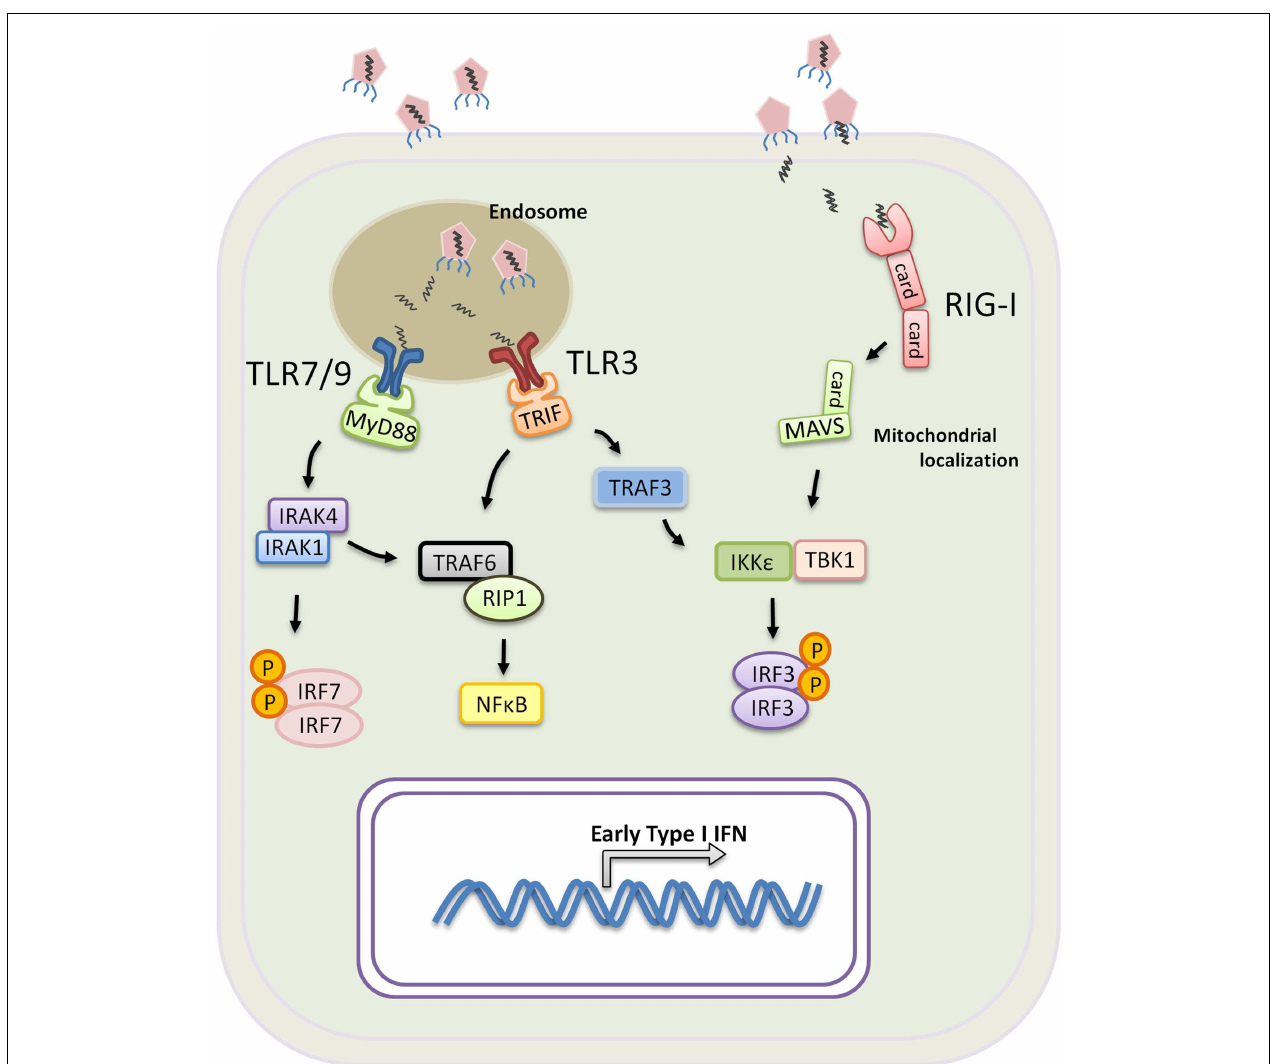
activation.Trif also bindsTRAF3 leading toTRAF3 K63-linked ubiquintination, facilitating the recruitment ofTBK1, IKK ε and IRF3 for IRF3 phosphorylation. Phosphorylated IRF3 homo-dimerizes and translocates into the nucleus for transcription ofType I IFN genes. RIG-I or RIG-I like receptors are expressed in all nucleated cells, and they recognizes viral RNA found in the cytoplasm. Upon activation, RIG-I recruits MAVS through the CARD domain interaction, and, analogous toTRIF, MAVS further binds IKK ε ,TBK1 and IRF3 to promote IRF3-activation andType I IFN